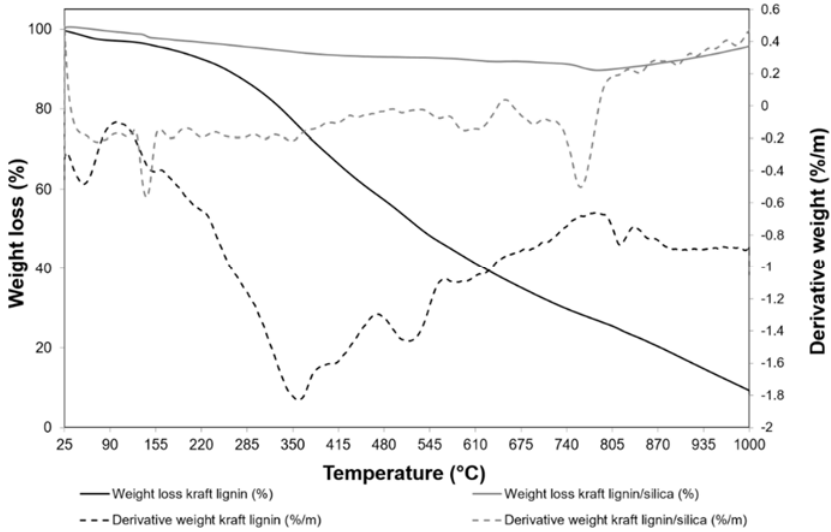
Figure 7. Thermograms of kraft lignin and the kraft lignin/silica system.